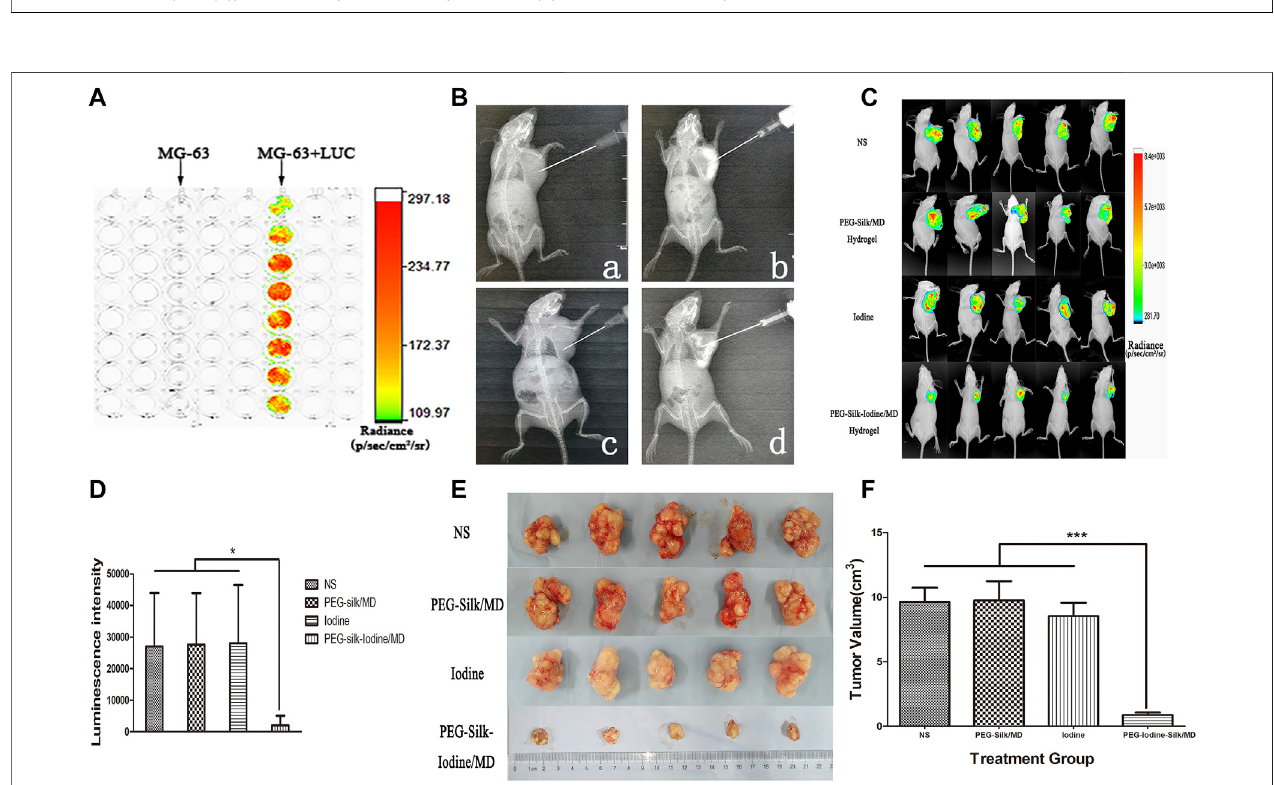
FIGURE6| Iodine-loadedhydrogelsinhibitOSgrowth invivo . (A) ThebioluminescenceofMG-63cellsaftertransfectionwithluciferase. (B) Arepresentativeimage of the injectable hydrogels in the X-ray fi eld. The image shows the distribution of the imageable hydrogels in the OS. a, Control group mice were inoculated with normal saline. b, PEG-silk/MD hydrogel group mice were inoculated with PEG-silk/MD hydrogel. c, Iodine group mice were inoculated with PVP-I. d, PEG-iodine-silk/MD hydrogel group mice were inoculated with PEG-iodine-silk/MD hydrogel. (C) The bioluminescence imaging of OS in vivo . (D) Quanti fi cation of bioluminescence signals from OS-bearing mice. (E) A representative image of xenograft OSs in the four groups. (F) Volume of xenograft OSs in nude mice after 42 days of hydrogel and saline injection. The data are presented as the mean ± SD. (* p < 0.05, *** p < 0.001.) (OS, osteosarcoma; PEG, polyethylene glycol; MD, meglumine diatrizoate; PVP-I, polyvinylpyrrolidone iodine;SD, standard deviation).